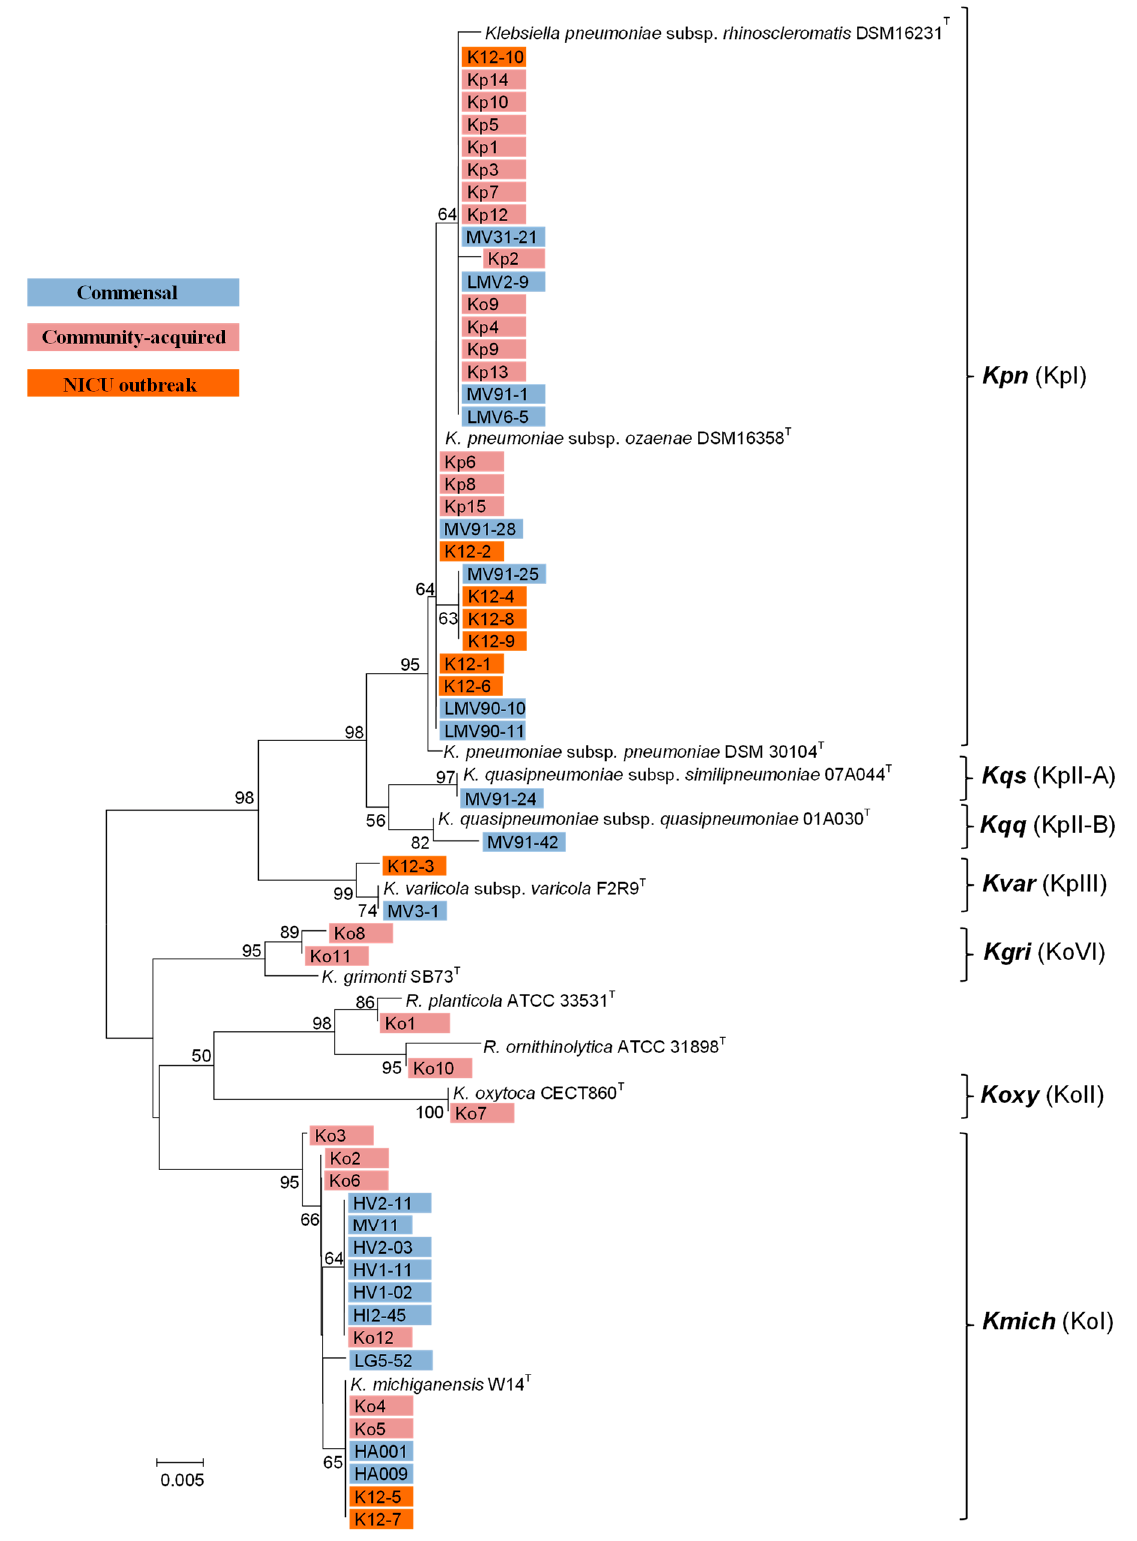
Figure 1. Phylogenetic relationships of 56 Klebsiella isolates and reference type strains by comparison of partial rpoB gene sequences (454 bp): The tree was based on the neighbour-joining method, using the Jukes–Cantor parameter model. Numbers on the tree indicate bootstrap values calculated for 1000 subsets for branch-points greater than 50%. Bar, 0.005 nucleotide changes per nucleotide position. Phylogenetic groups (KpI, KpII-A, KpII-B, KpIII, KoII, KoVI and KoI) are shown in brackets (Kpn: K. pneumoniae ; Kqs: K. quasipneumoniae subsp. similipneumoniae ; Kqq: K. quasipneumoniae subsp. quasipneumoniae ; Kvar: K. variicola ; Kgri: Klebsiella grimontii ; Koxy: K. oxytoca ; Kmich: K. michiganensis ).